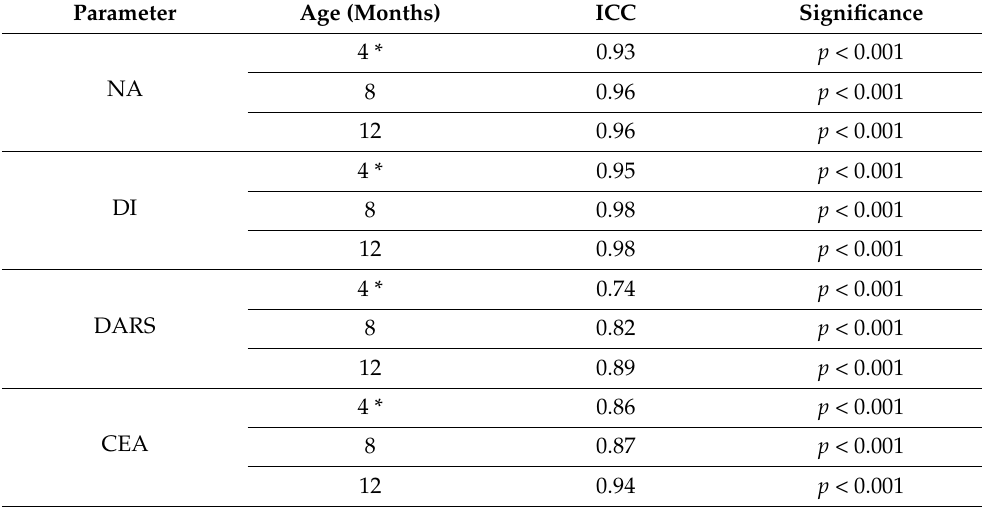
Table 2. Intraclass correlation coefficient (ICC) for interobserver variability between observers.